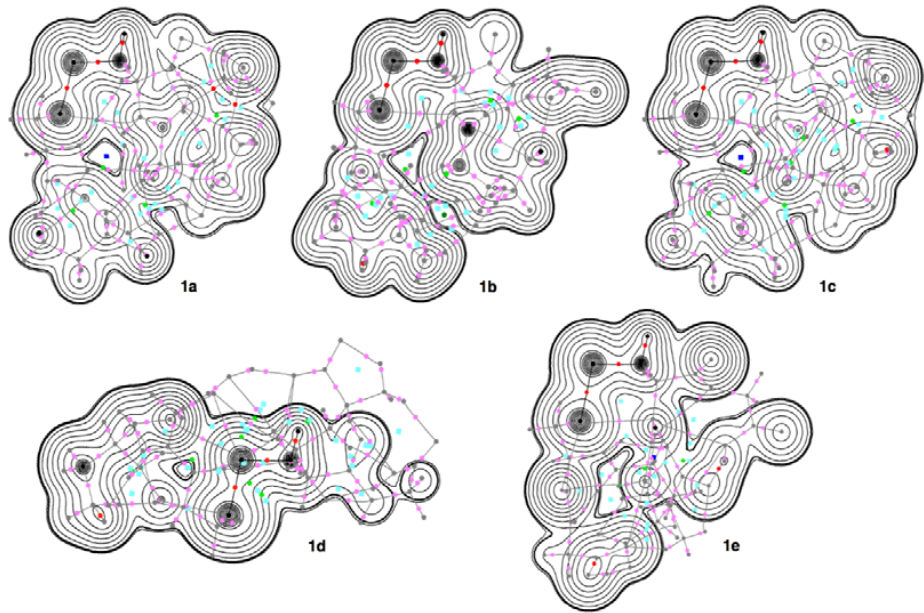
Figure 7. Contour plots of ρ b ( r c ) drawn on the SSC planes of 1a – 1e , together with BCPs (red solid dots on the plane and pink solid dots out of the plane), RCPs (ring critical points: deep green solid squares on the plane and green solid squares out of the plane), CCPs (cage critical points: blue solid dots on the plane and cyan solid dots out of the plane) and bond paths (black solid lines). The contours ( ea o–3 ) are at 2 l ( l = ±8, ±7, …., 0) with the heavy line of 0.0047 for the molecular surface.